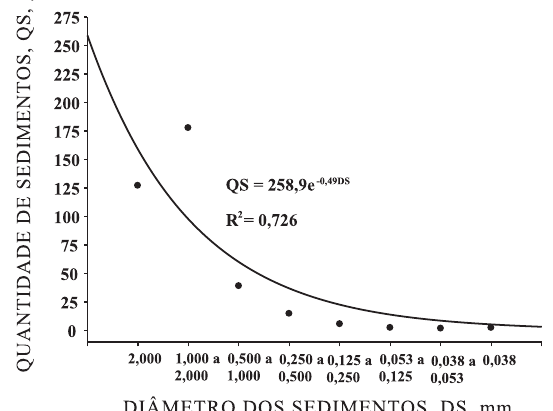
tratamentos).Figura dos tratamentos e dos testes de chuva simulada).